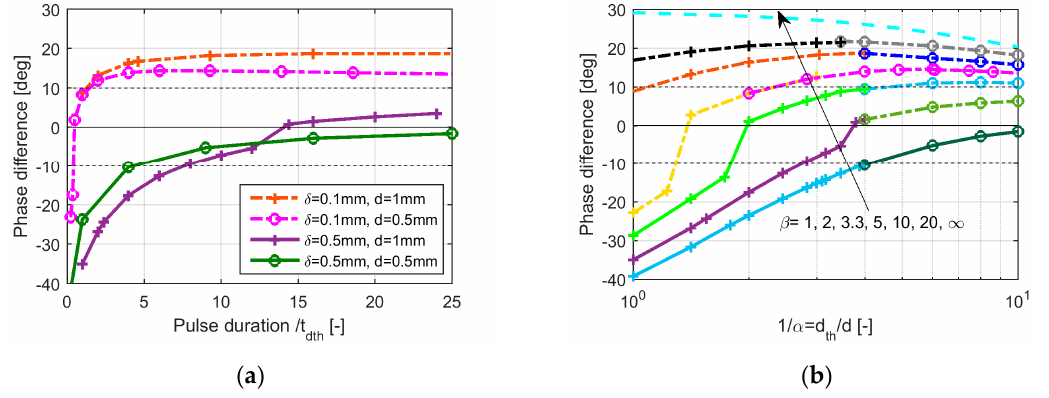
Figure 24. ( a ) Phase difference for two cracks calculated for two different penetration depths; ( b ) phase difference in a normalized manner for ferro-magnetic (dash-dot lines) and for non-magnetic (solid lines) steel. Values marked with “+” are calculated for d = 1 mm and with “o” for d = 0.5 mm.